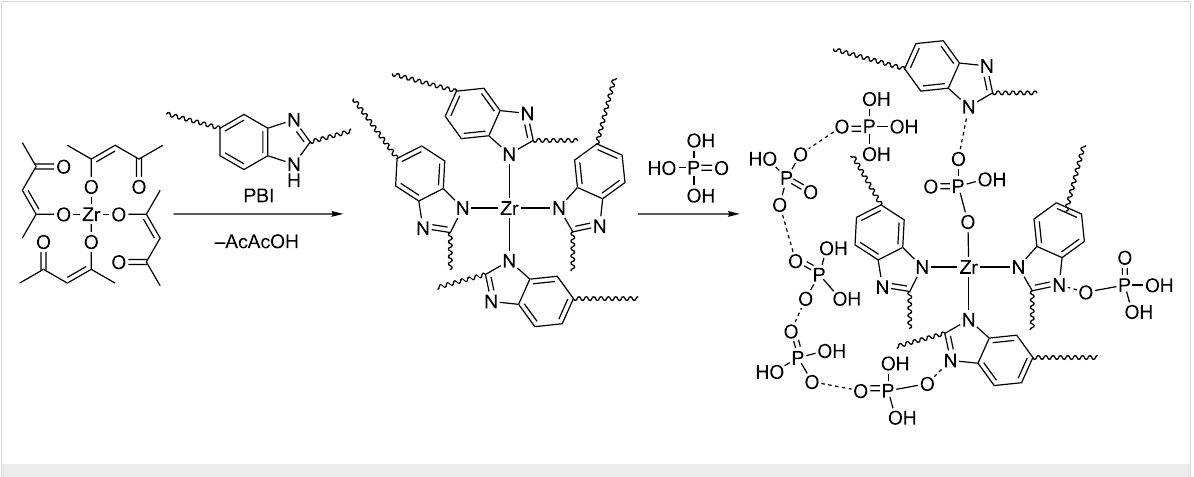
Figure 5: Possible mechanism of the crosslinking process of PBI by Zr(acac) 4 and further doping with PA.